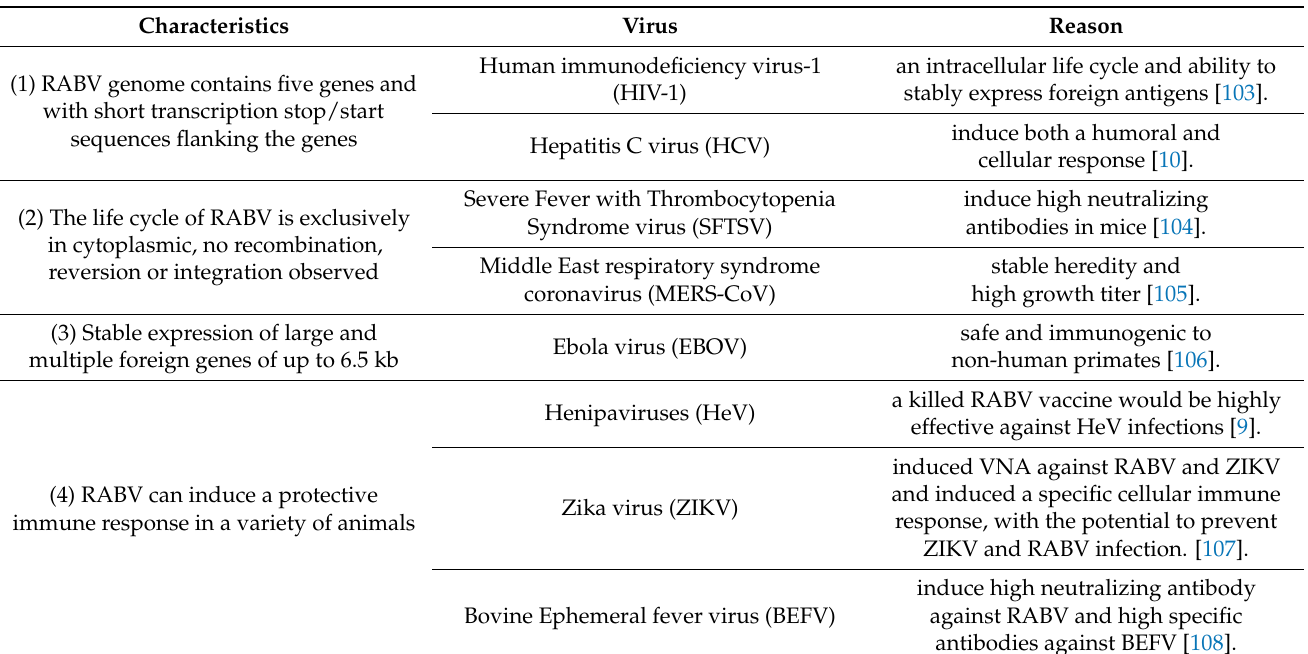
Table 3. RABV-Based Vectors as Vaccines Against Other Infectious